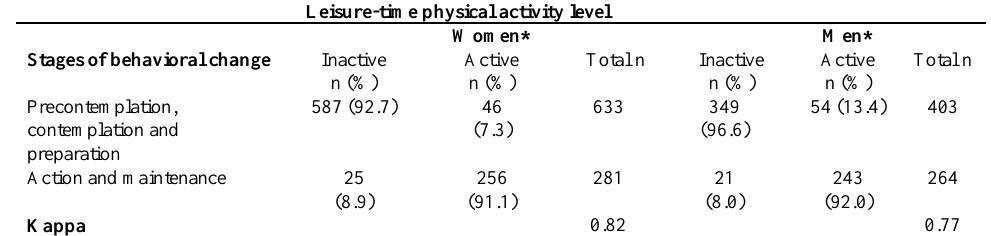
Table 2. Concordance between Stages of Behavior Change Questionnaire (SBCQ) and International Physical Activity Questionnaire (IPAQ). Data representative of women and men. .